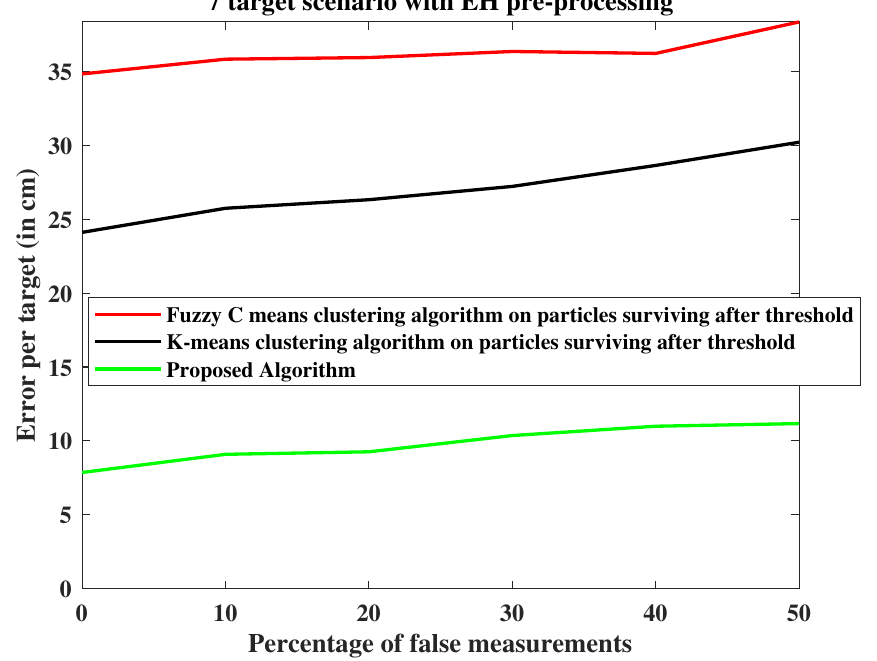
Figure 9. Performance comparison with false measurements and for σ = 0.1 and no missing